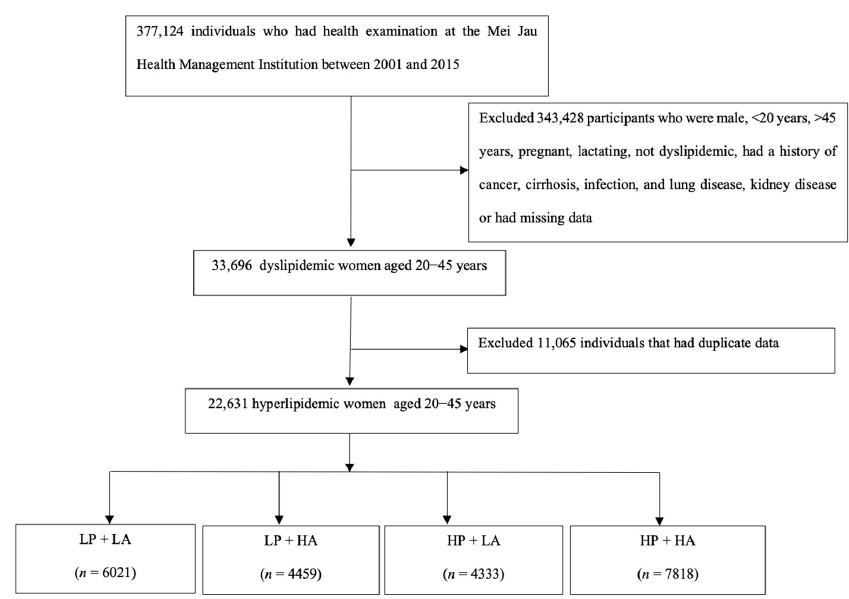
Figure 1. Flow chart diagram of subjects included in the study. LP: low plant diet, LA: low animal diet, HA: high animal diet, HP: high plant diet.